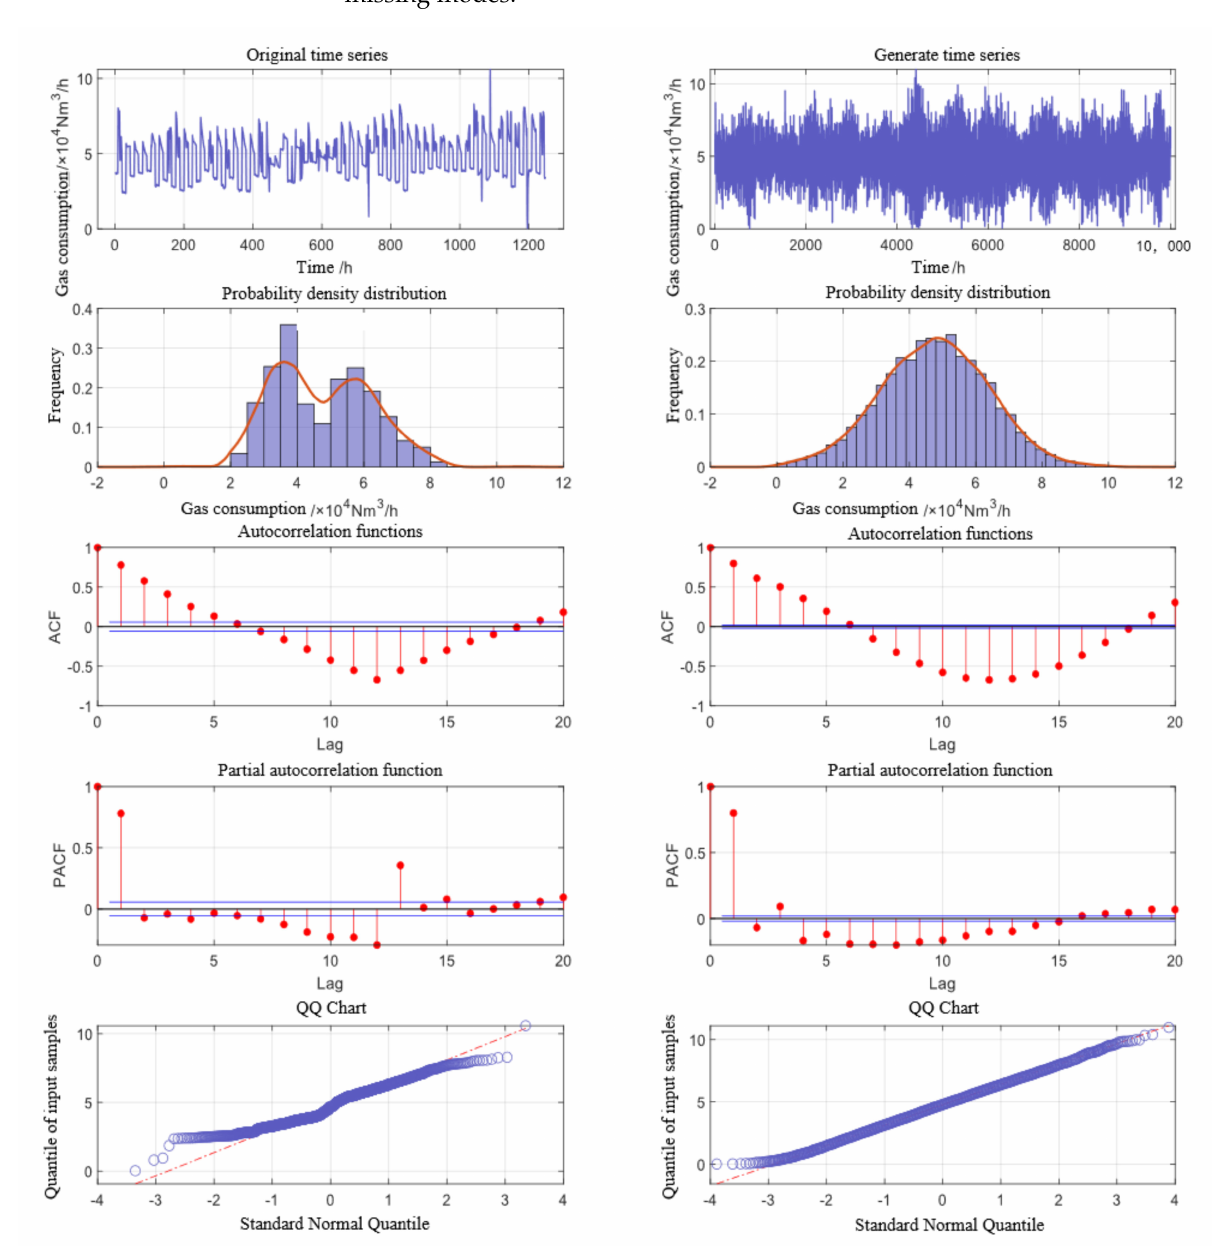
Figure 9. Analysis of time series characteristics between original data and generated